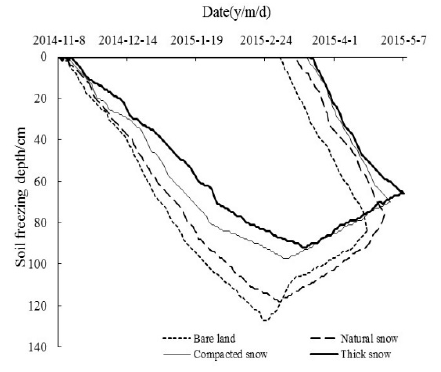
Figure 4. The soil freezing process curve.